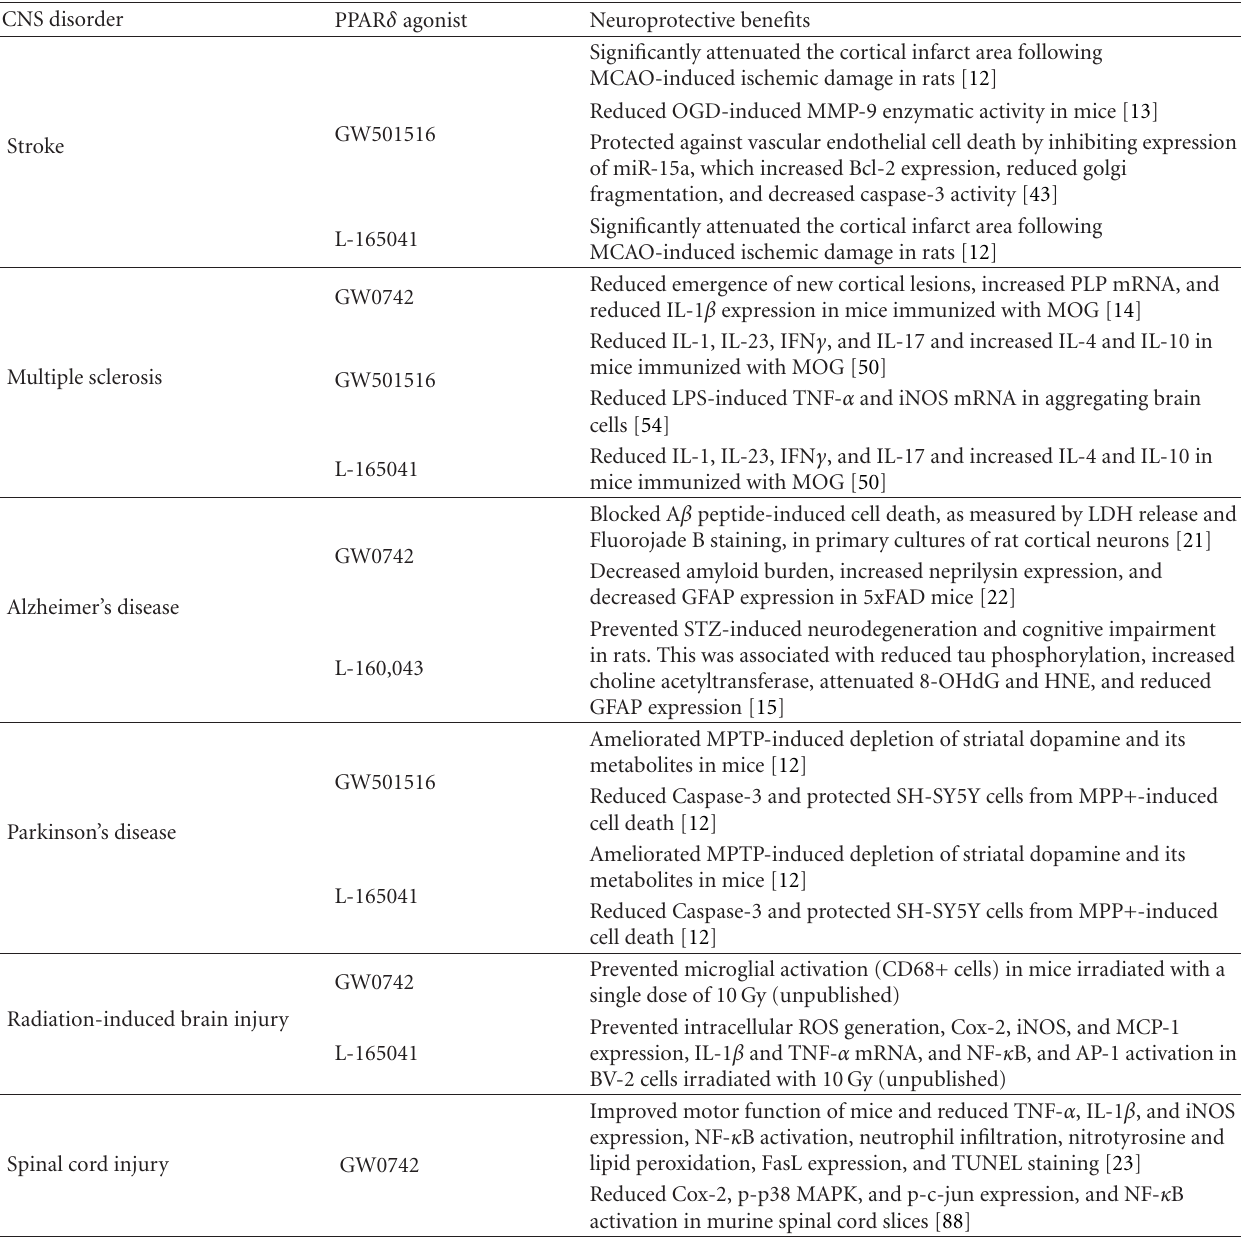
Table 1: The neuroprotective benefits of PPAR δ